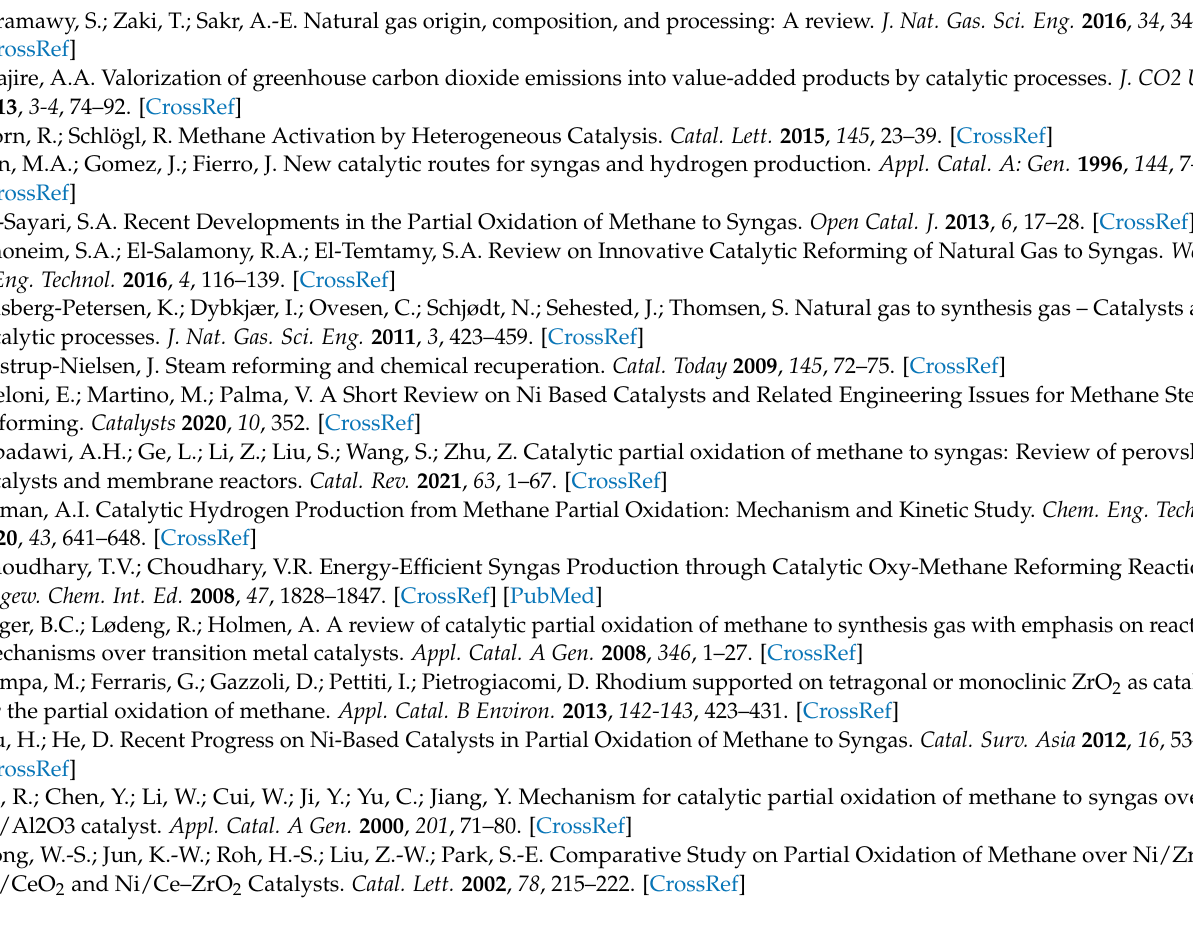
tion/desorption isotherms (a) and pore size distributions (b) for the Z m support and NiO/ZrO 2 catalyst precursors. Figure S3: Reproducibility of activity in four subsequent runs on two represen- tative samples activated by the ox-red treatment (a) or by the red treatment (b). Figure S4: Percent H 2 selectivity (a) and percent CO selectivity (b) for Ni/ZrO 2 catalysts after red activation treatment as a function of temperature. Figure S5: Catalytic activity of 5.1Ni/Z m ( red ) catalyst at 923 K with different total flow rates. CH 4 conversion and H 2 , CO 2 and H 2 O yields as a function of time on stream. Figure S6: Catalytic activity of 1.8Ni/Z m ( red ) catalyst at 1023 K with different O 2 contents in the feed. CH 4 conversion and H 2 , CO 2 and H 2 O yields as a function of time on